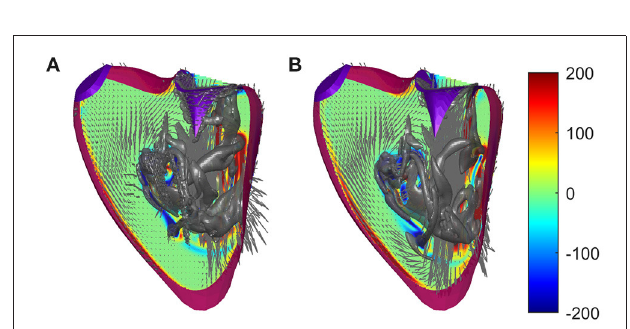
FIGURE 3 | Flow fields in a normal right ventricle (RV) at peak E-wave computed (A) with regular viscosity and (B) with the enhanced viscosity at the immersed boundary using identical numerical parameters. The normal vorticity is shown by red to blue color from –200 to 200 units equal to the inverse of the heartbeat period and the velocity vector (ever 4 grid points) on a longitudinal plane; the three-dimensional gray surfaces represent the iso-surface of λ 2